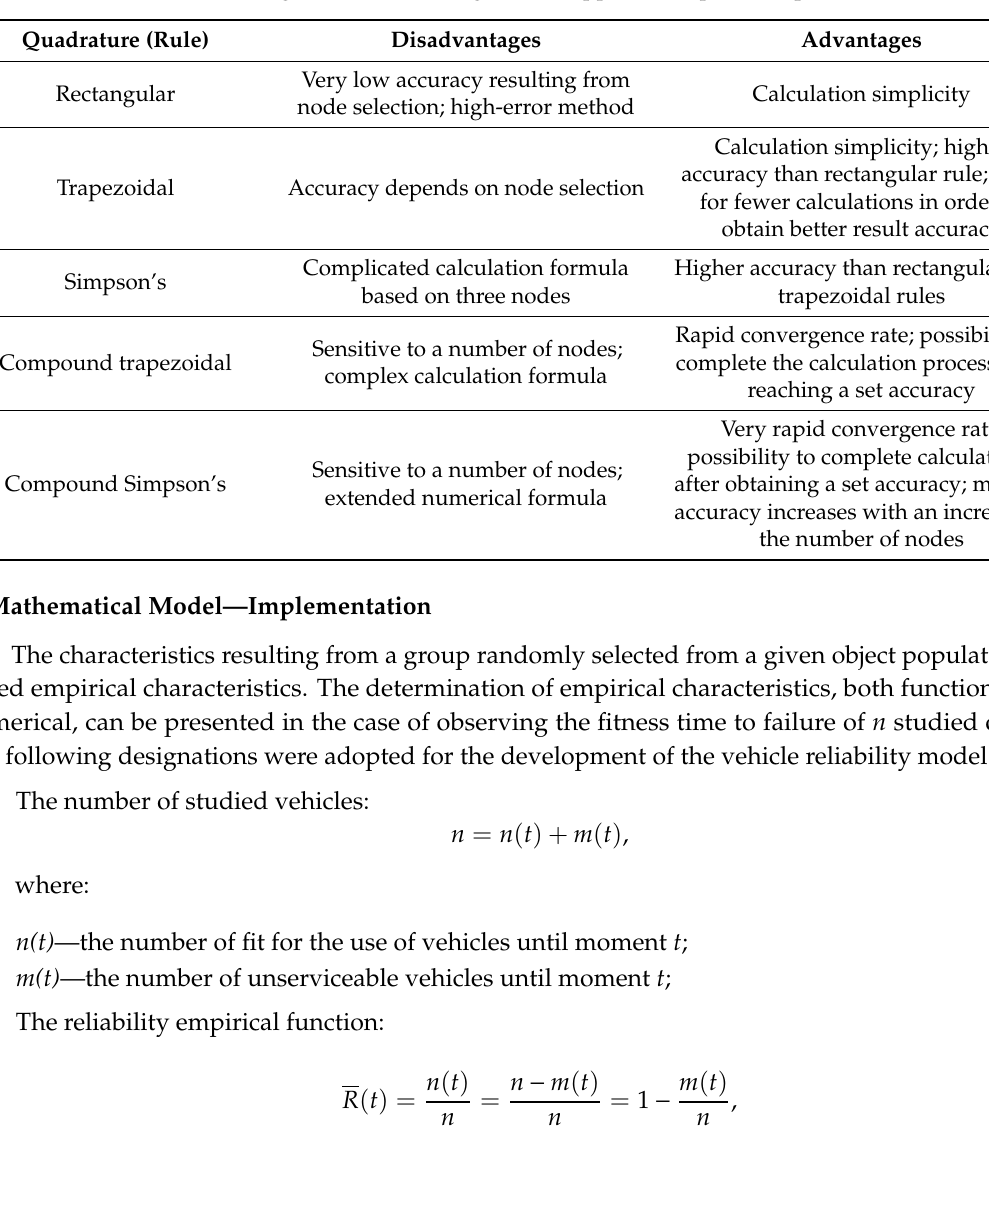
Table 1. Advantages and disadvantages of the applied interpolation